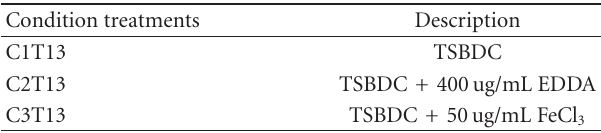
Table 1: Culture